Question: Condense the content of this figure into a single sentence.
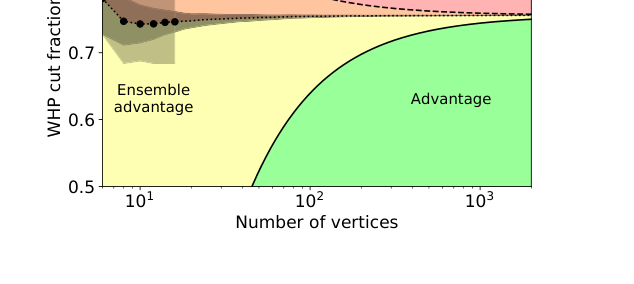
Answer: p = 2 QAOA cut fraction guarantees under different assumptions. Dashed and solid lines plot with high probabil- ity the lower and upper bounds on cut fractions, respectively, assuming only graph theoretic typicality on the number of subgraphs. Dotted plots are the ensemble median over an en- semble of 3-regular graphs; for N ≤16 (dots); this includes all graphs, while for N > 16 this is an ensemble of 1,000 graphs for each size. We used 32 sizes between 16 and 256. Dark black fill plots the variance in the cut fraction over the ensemble, and light black fill plots the extremal values over the ensemble. The median serves as a proxy of performance assuming QAOA typicality. Given a particular cut from a classical solver, there may be different regions of advantage, shown by the four colors and discussed in the text.